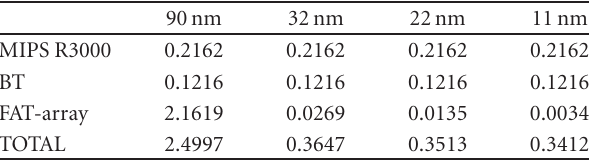
Table 3: Estimated chip size (mm 2